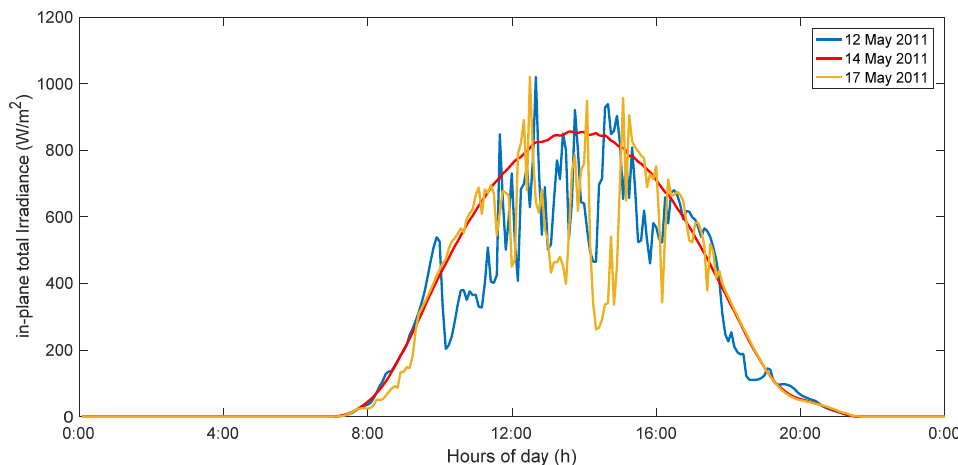
Figure 13. Daily profiles of the direct current, I dc , produced in the set of 36 PV modules during 12, 14 and 7 May 2011.